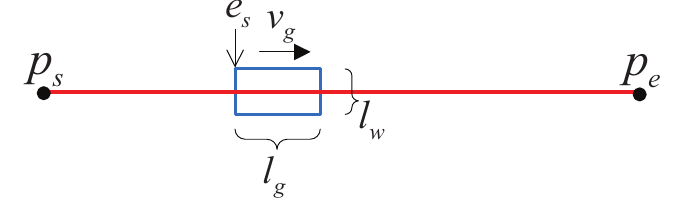
Figure 5. Virtual path and virtual